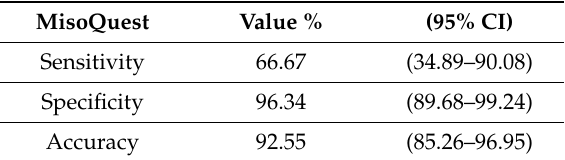
Table 1. Sensitivity, specificity, and accuracy of MisoQuest.